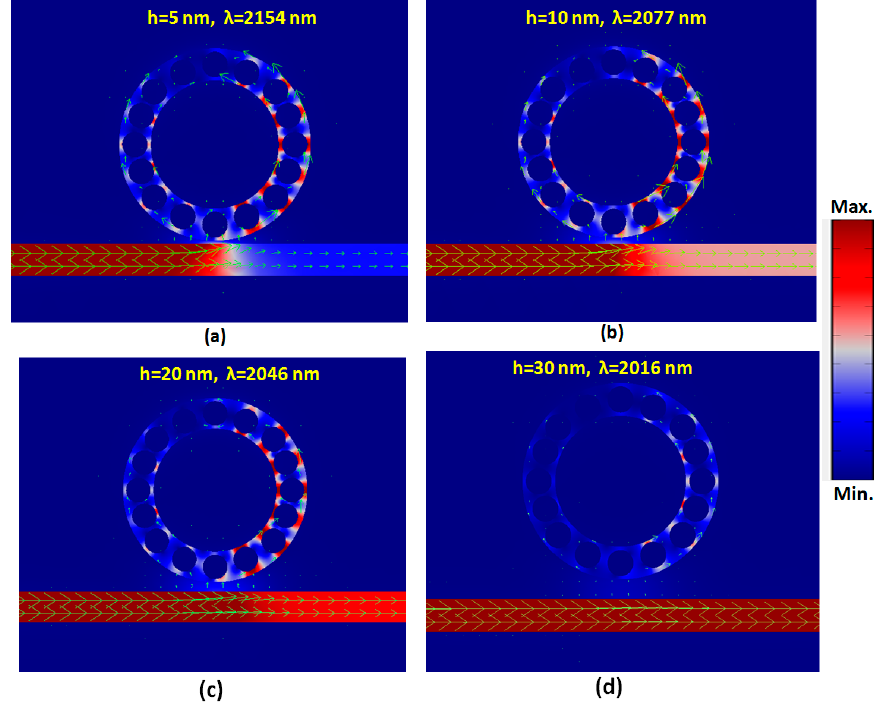
Figure 8. Truncate views of power flow intensities (W/m 3 ) with energy arrows (green lines) for the cases of ( a – d ) h =5, 10, 20, and 30 for mode 1, respectively.